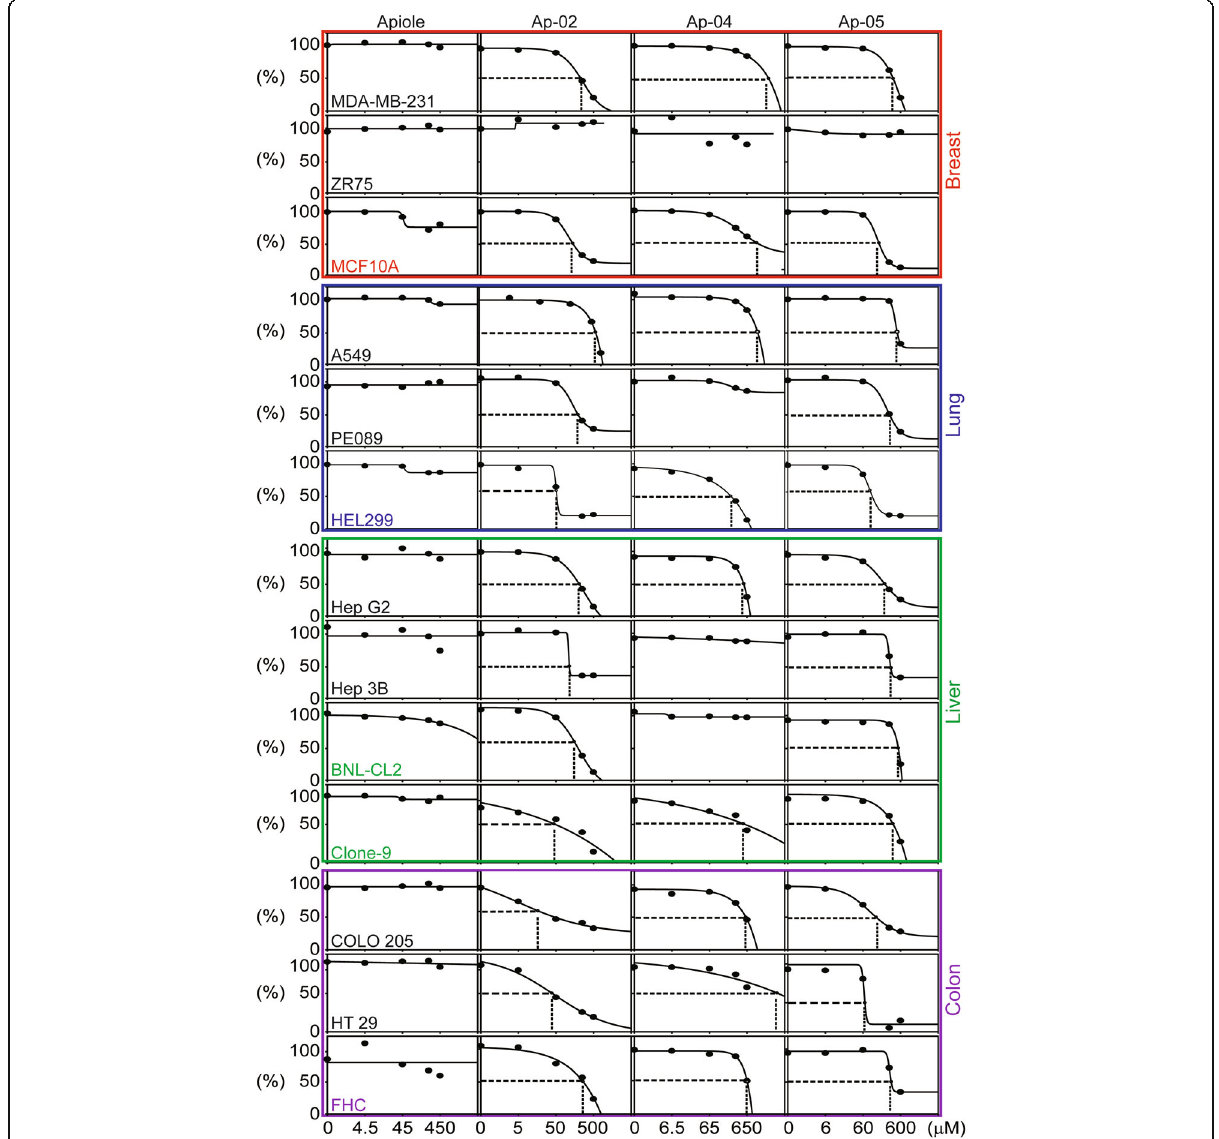
Fig. 3 Cytotoxicity of apiole and its derivatives (AP-02, AP-04 and AP-05) in human cancer cells and normal cells. In this study, human breast (MDA-MB-231, ZR75), lung (A549, PE089), liver (Hep G2, Hep 3B), and colon (COLO 205, HT 29) cancer cells, as well as normal human breast (MCF 10A), lung (HEL 299), liver (BNL-CL2, Clone 9), and colon (FHC) cells were treated with compounds (apiole, Ap-02, Ap-04, and Ap-05; 4.5 – 600 μ M) for 24 h, and IC50 values were